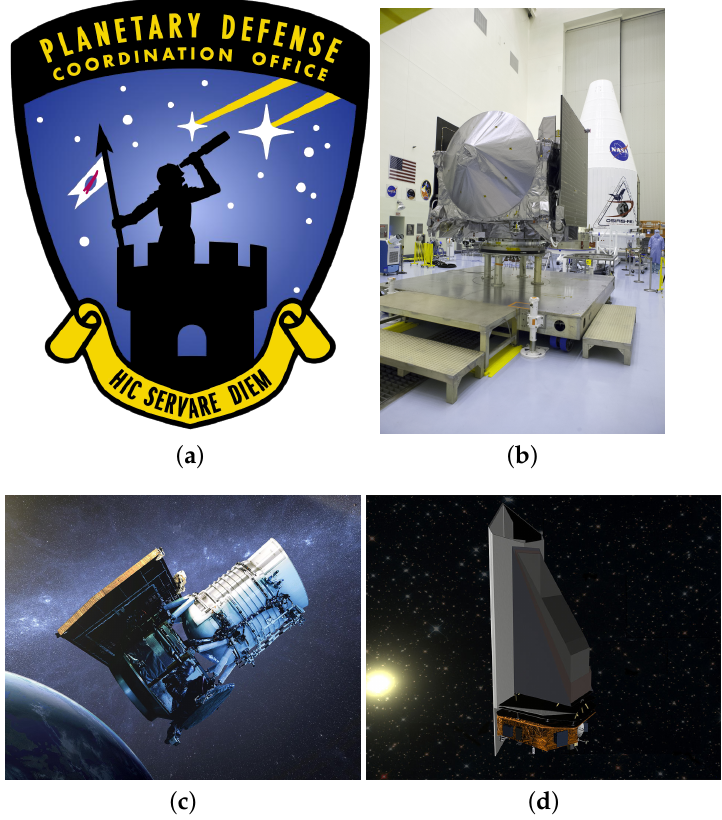
Figure 11. ( a ) The seal of NASA’s Planetary Defense Coordination Office (PDCO) [111]; ( b ) OSIRIS- REx in launch configuration [112]; ( c ) artist’s concept of the Wide-field Infrared Survey Explorer (WISE) spacecraft in its orbit around Earth [113]; ( d ) artist’s illustration of the NEOCam (NEO Surveyor) space telescope